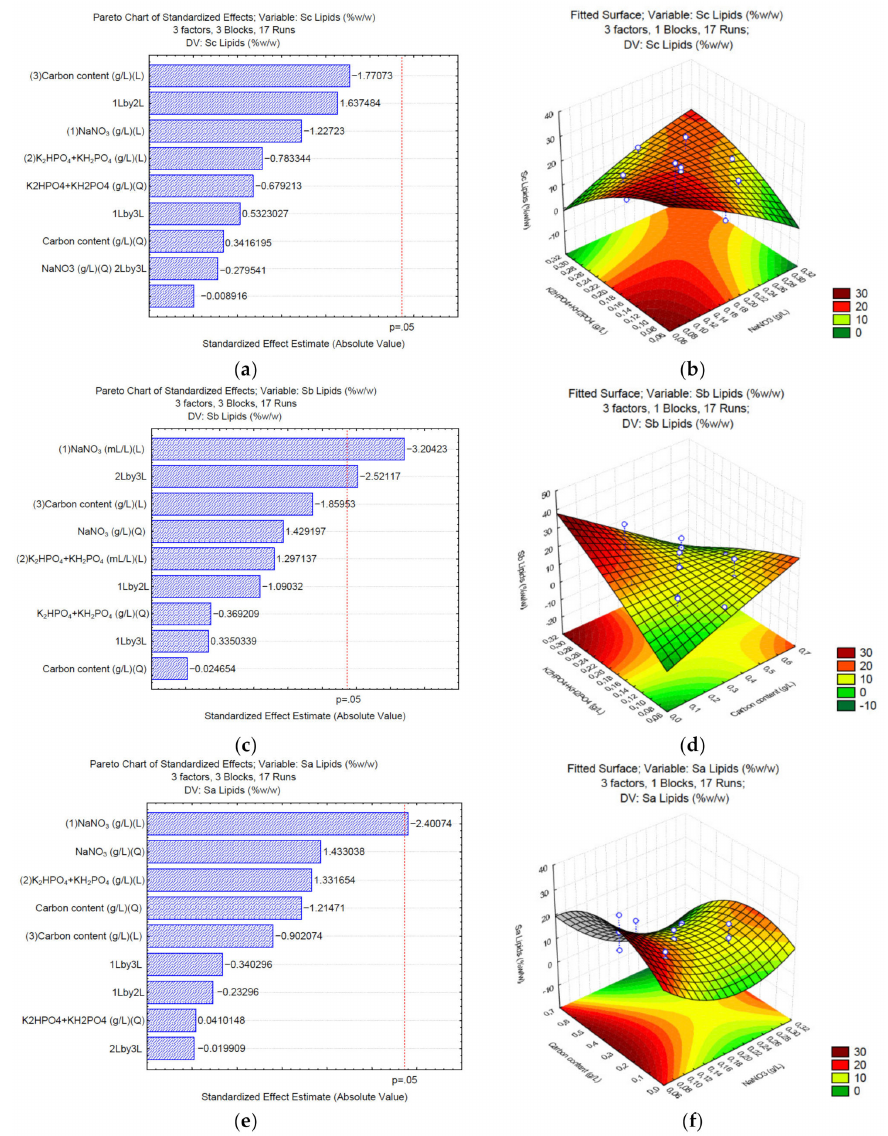
Figure 3. Pareto charts and surface response of lipid production using Na 2 CO 3 ( a , b ), NaHCO 3 ( c , d ), and C 2 H 3 NaO 2 ( e , f